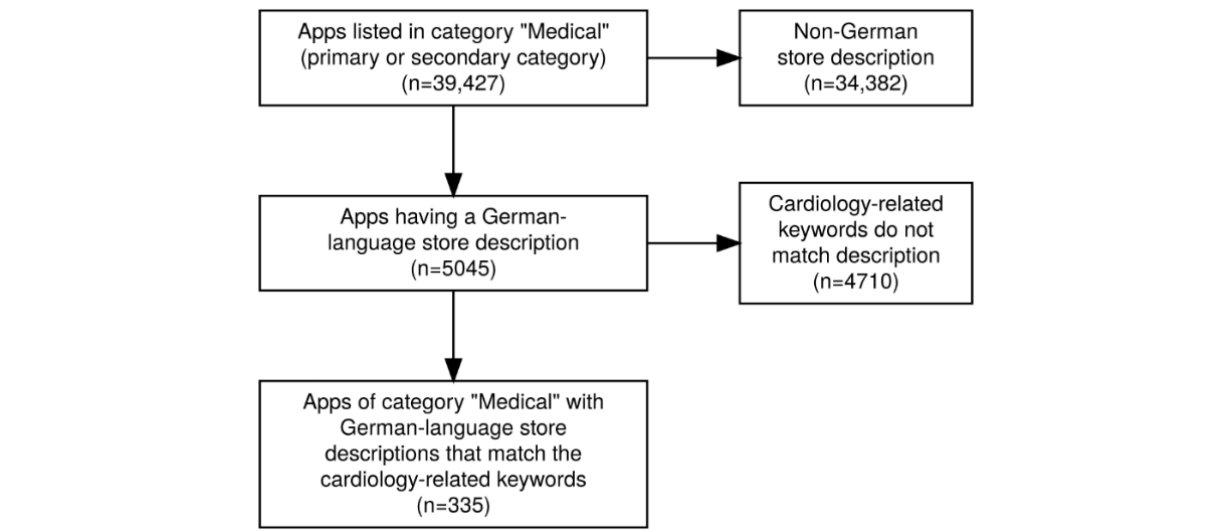
Figure 3. Acquisition and keyword-based selection process for the 335 cardiology-related apps.